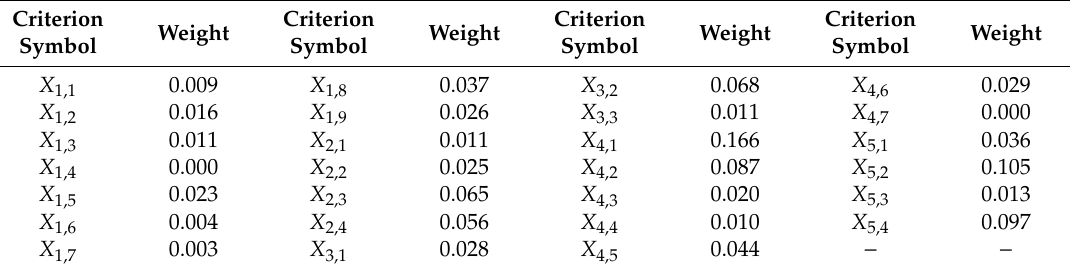
Table 11. Global weights of specific